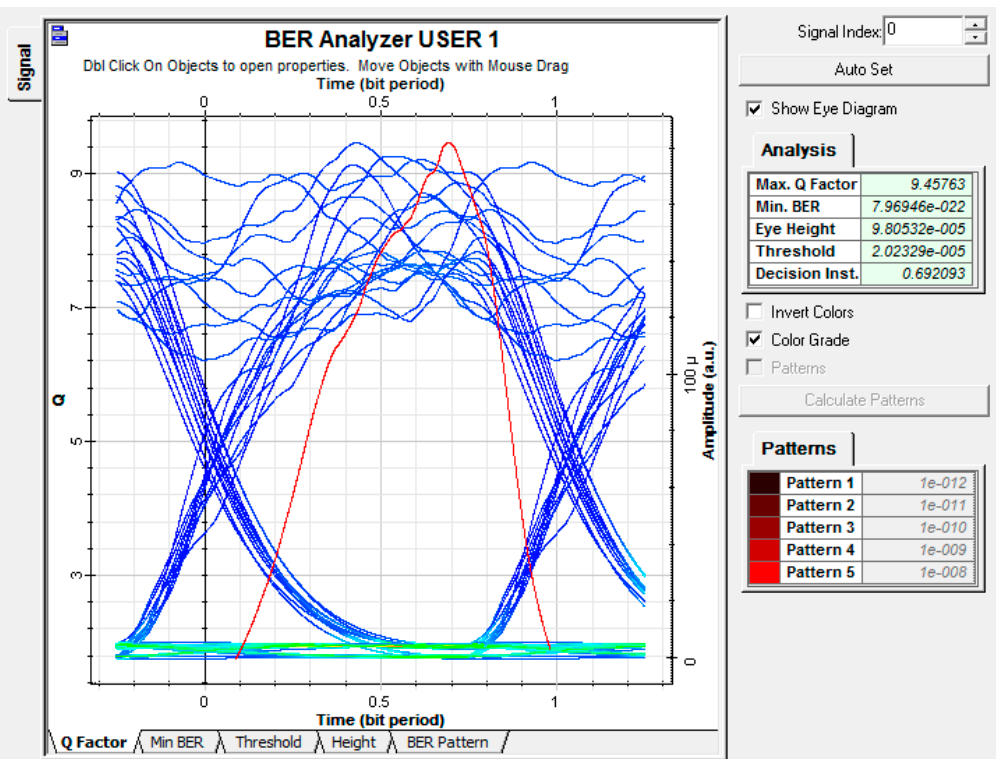
Figure 18. Diagram of the first user’s eye at 2 Gbps.